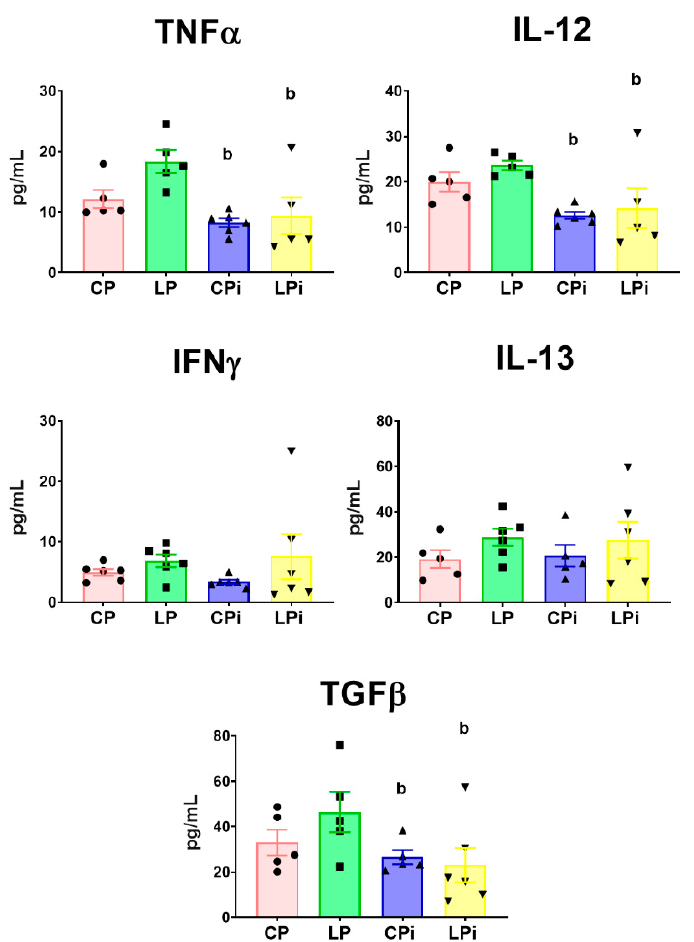
Figure 6. Cytokines levels in the luminal fluid of duodenum from malnourished BALB/c mice infected with L. infantum . TNF α , IL-12, IFN γ , IL-13 and TGF β protein levels were measured in the luminal fluid of the duodenum at 14 days post-infection using a flow cytometry-based multiplex assay. Significant differences due to infection (b), p < 0.01 for TNF α and IL-12 and p < 0.05 for TGF β , as determined by two-way ANOVA. CP: animals fed 14% protein diet; LP: animals fed 4% protein diet, CPi: animals fed 14% protein diet and infected; LPi: animals fed 4% protein diet and